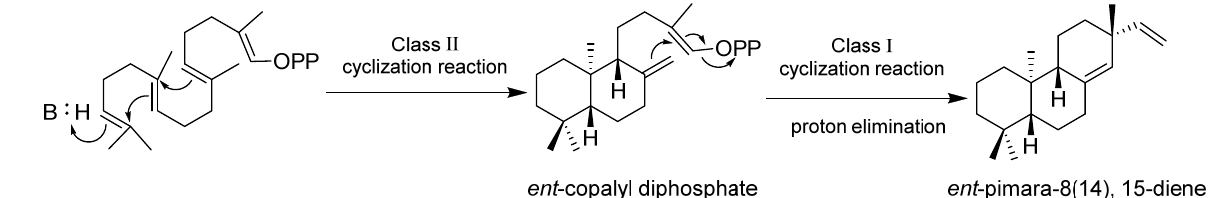
Figure 21. Biosynthesis of ent -pimara-8(14), 15-diene.